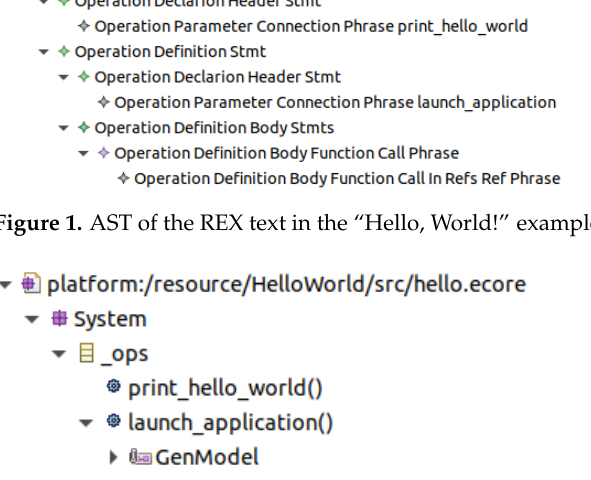
Figure 2. Ecore model compiled from the REX text in the “Hello, World!” example. Listing 4. Java code generated by EMF from the Ecore model compiled from the REX text in the “Hello, World!” example